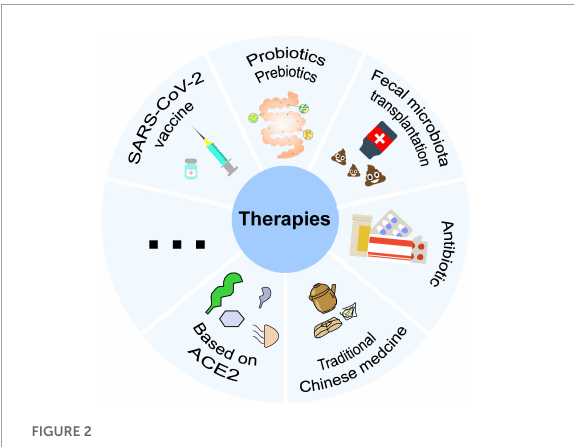
FIGURE2 Potential COVID-19 therapies associated with microbiota such as prebiotics and prebiotics, fecal microbiota transplantation, antibiotics, traditional Chinese medicine, SARS-CoV-2 vaccine, and treatment based on ACE2,